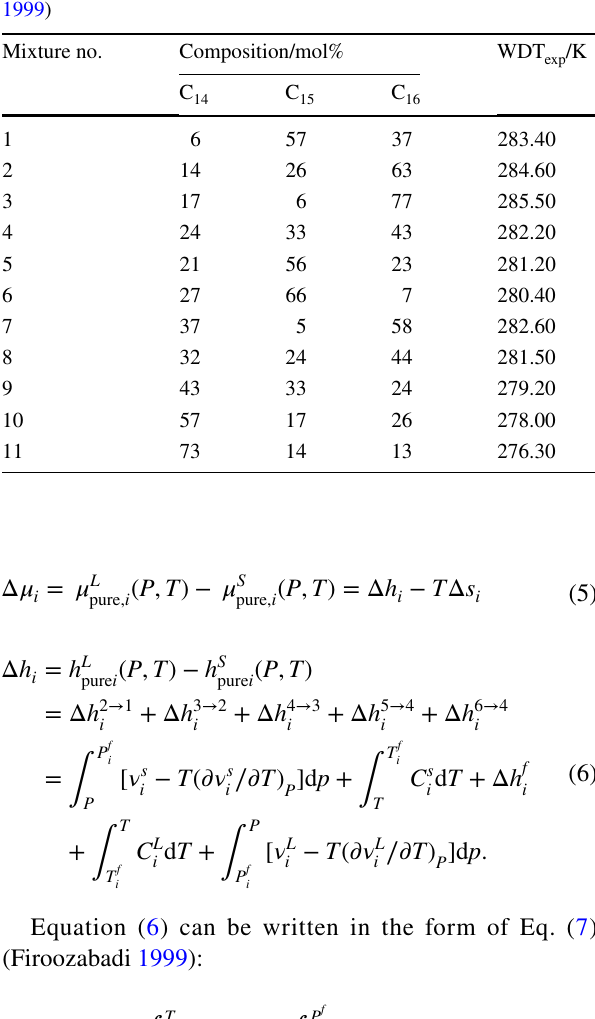
Table 3 Laboratory WDT/K values for system #1 (Metivaud et